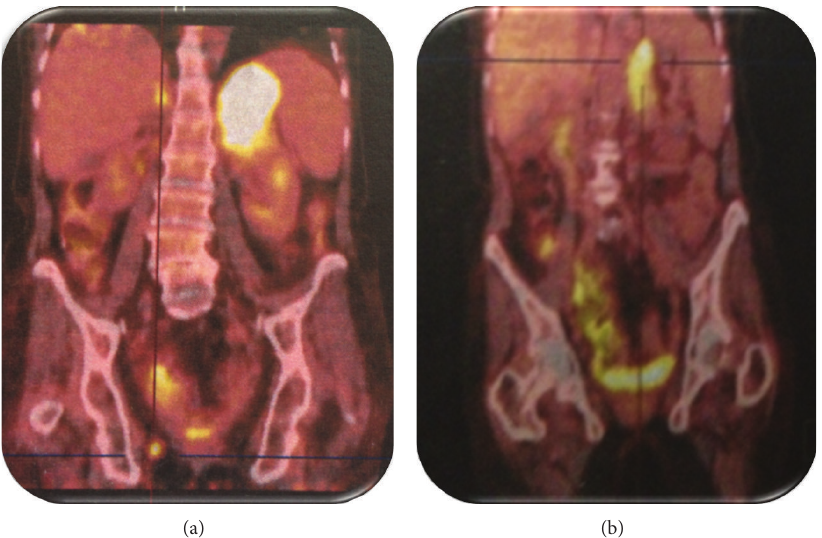
Figure 3: (a) PET scan showed suspicious hypermetabolic sites in the left suprarenal gland, lomboaortic nodes, liver, and the left kidney. (b) PET scan showed a remission estimated at 90% on the left suprarenal gland and the disappearance of the metastasis at the level of the other sites after